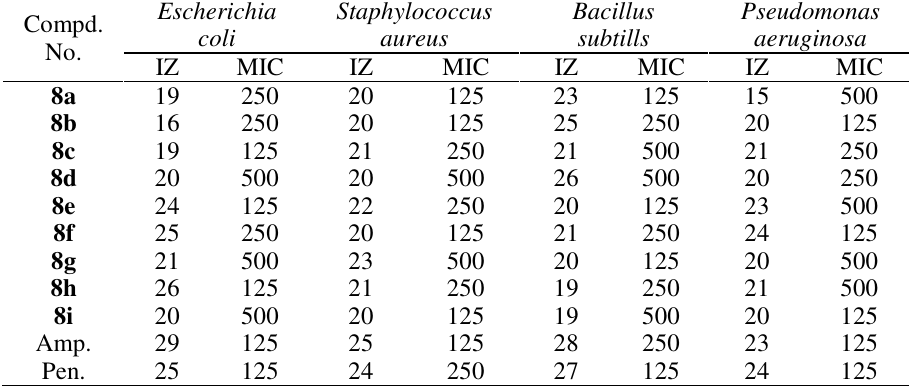
Table 1. Antimicrobial activity of the tested compounds ( 8a-i )